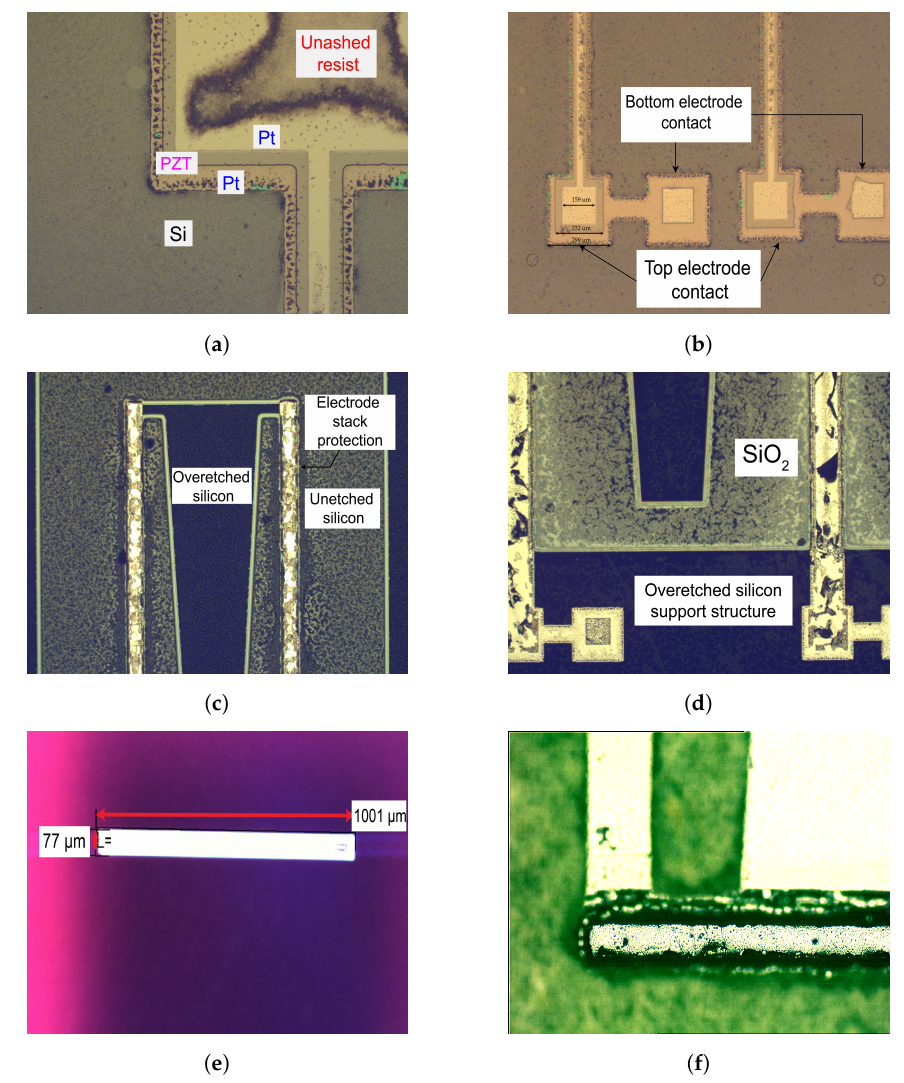
Figure 8. ( a ) Electrode layout after the top electrode fabrication process steps under an optical microscope for a single cantilever; ( b ) Contact pads for each side beam of M-shape cantilevers. The intention is to connect the two electrodes in series; ( c ) Presence of unetched silicon due to uneven etching of the wafer; ( d ) Areas where SiO 2 is visible after topside etching; ( e ) Proof mass on M-shape realized after the first backside etch process; ( f ) Etched proof mass connected to topside cantilever structure after wafer-through